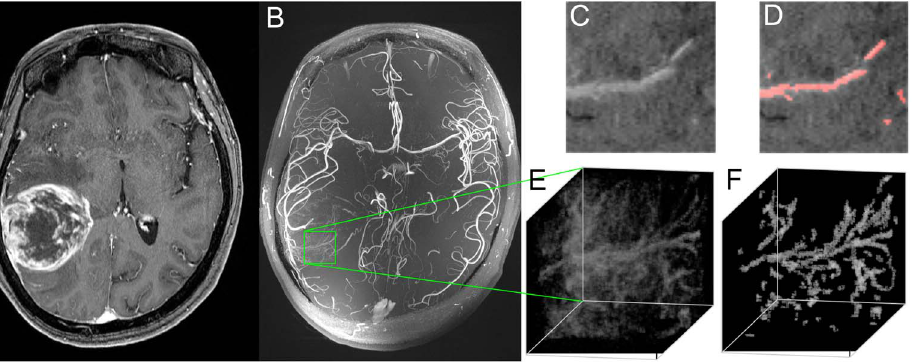
Figure 2. Demonstration of multiscale vessel enhancement filtering. A) Contrast enhanced T1 weighted images at 3 Tesla of a patient with right temporal glioblastoma. B) 7 Tesla ToF angiography maximum intensity projection. Within the selected VOI (E) (representative slide in (C)), vessels are automatically detected and visualized (F) (representative slide with red colored vessels in